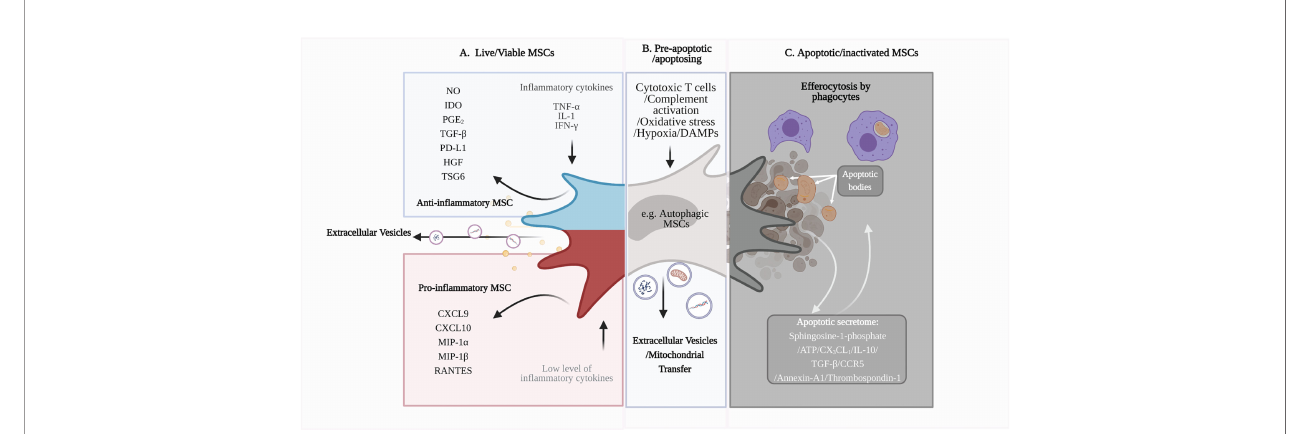
FIGURE 1 | Immunomodulatory capacity of viable and apoptotic MSCs. (A) Live or viable MSCs can sense the microenvironment and respond to cytokine signals by polarizing into ‘ pro-in fl ammatory ’ or ‘ anti-in fl ammatory ’ phenotypes (24). ‘ Anti-in fl ammatory ’ MSCs produce anti-in fl ammatory soluble factors, including IDO and TGF- b , to modulate immune cell function and dampen in fl ammation. MSCs also produce extracellular vesicles (EV), such as exosomes, that can be immunomodulatory, depending on their cargo (19, 25). (B) Excessive in fl ammatory stress or the presence of cytotoxic immune cells will induce apoptosis of MSCs (26). MSCs can undergo a pre- apoptotic stage, known as autophagy. Autophagic MSCs, as well as the EVs produced during this stage, may have roles in immunosuppression (27). (C) As MSCs undergo apoptosis, their apoptotic secretome can promote an anti-in fl ammatory microenvironment and attract phagocytes for efferocytosis (28). Phagocytes that have engulfed the apoptotic MSCs become immunomodulatory and have downstream regulatory effects on adaptive immune cells, such as T cells (29). Figure was created with